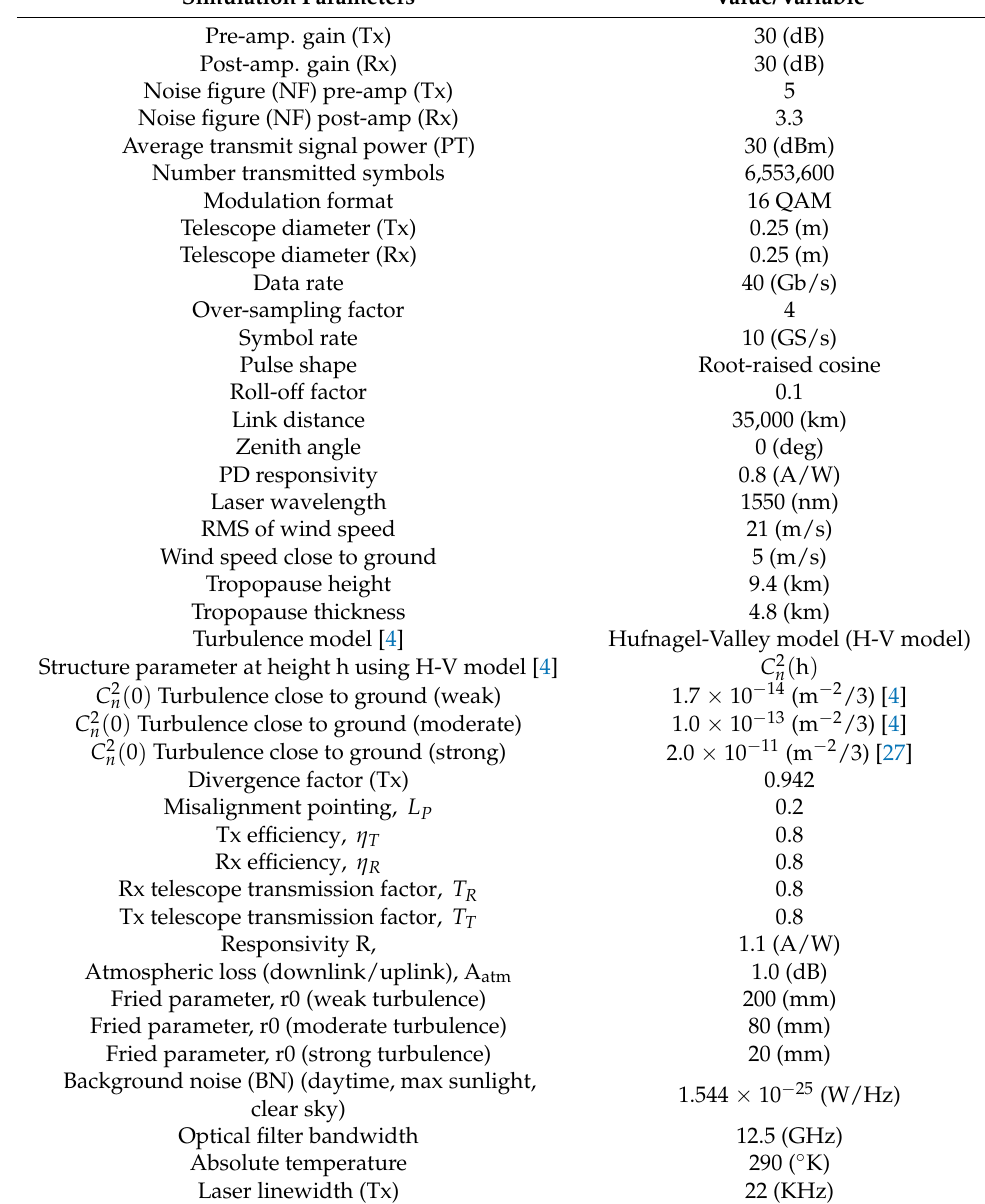
Table 1. FSO KK and coherent system simulation